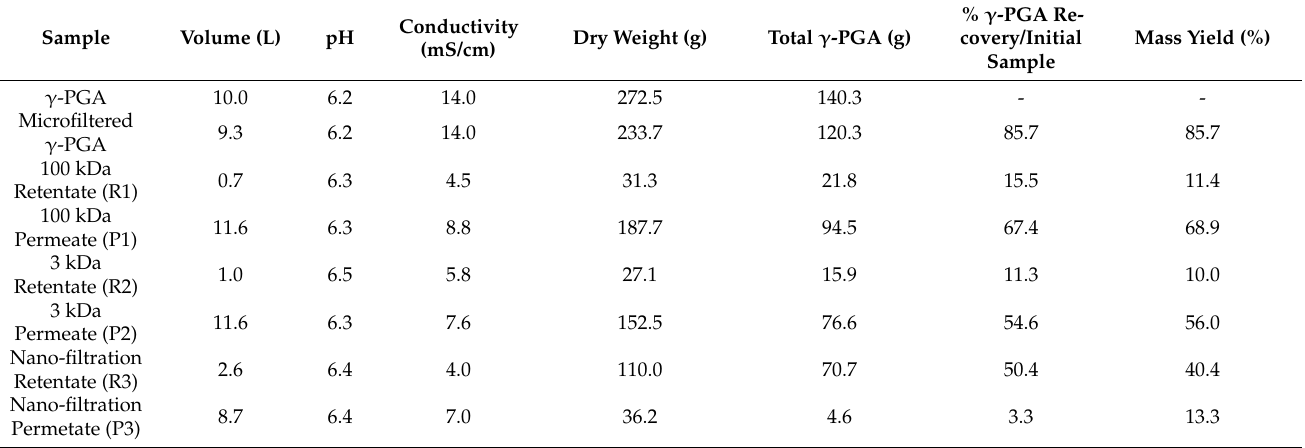
Table 1. Summarized data of the γ -PGA filtration membrane-based purification process. (ND, not determined). Mass yield values were calculated as percentage ratio of the mass value of each sample on the mass value of the initial